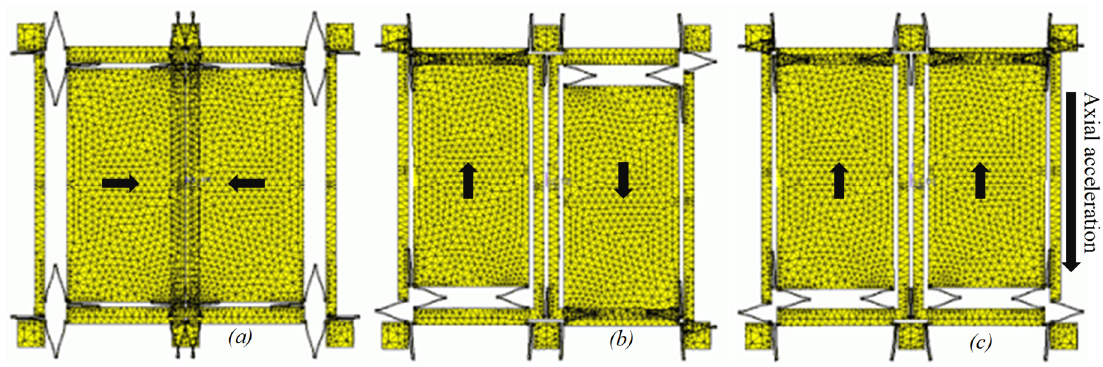
Figure 2. The gyroscope’s working modes. ( a ) Drive mode. ( b ) Sense mode with Coriolis force. ( c ) Sense mode with axial acceleration.